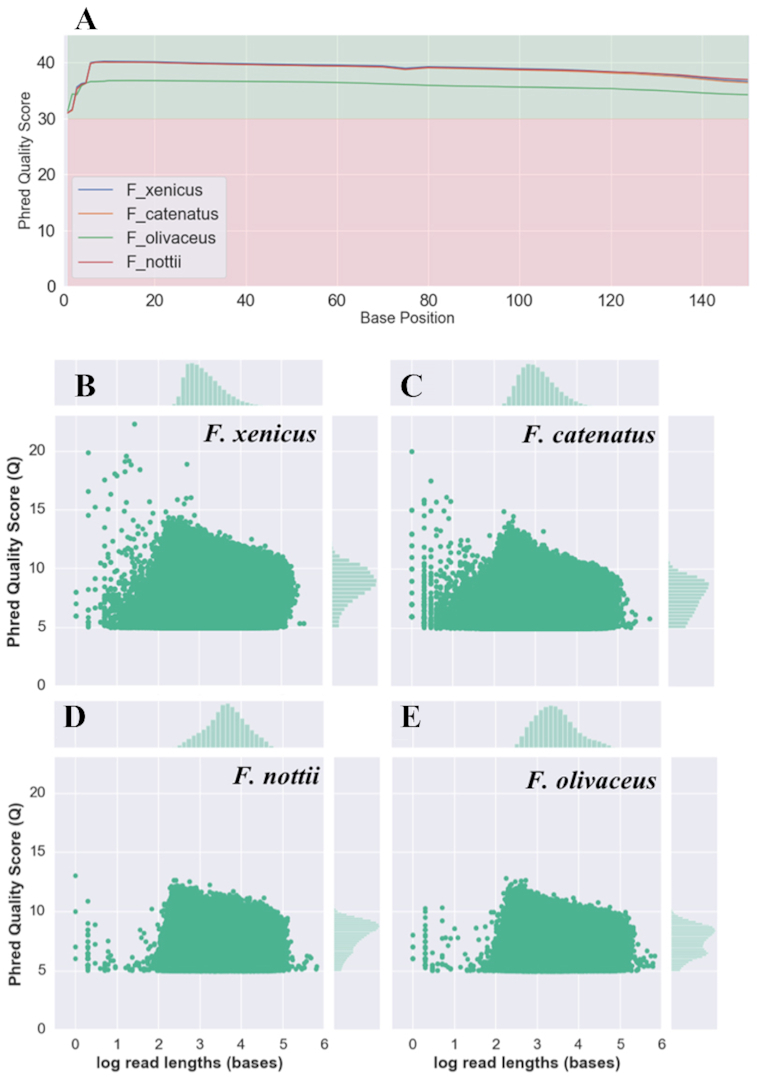
(A) Quality score profiles for representative R1 Illumina reads from F. xenicus, F. catenatus, F. nottii, and F. olivaceus. For Illumina data, phred quality scores were consistently above Q30 across all reads. Average read quality scores (Q score) vs. read lengths for ONT PromethION from (B) F. xenicus, (C) F. catenatus, (D) F. nottii, (E) F. olivaceus.